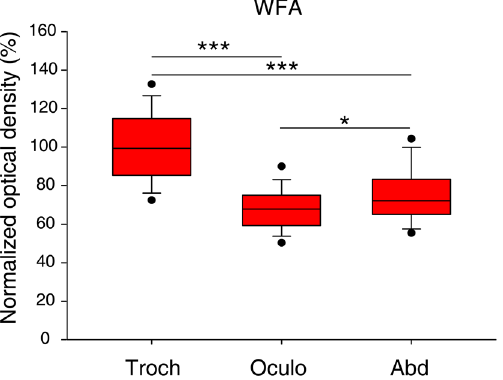
Figure 4. Optical densities of WFA reactions in the trochlear-, oculomotor- and abducens nuclei. Optical densities were normalized by the mean optical density of PNNs in the trochlear nucleus and expressed as percentages of this mean. Box plots represent the 10th, 25th, 50th 75th and 90th percentile values, lower and upper closed circles mark the 5th and 95th percentiles. There is a statistically significant difference in optical densities among the three nuclei (Kruskal–Wallis ANOVA on Ranks test, p < 0.001). Pairwise comparisons of optical densities revealed statistically significant difference between each pair of nuclei (Dunn’s post hoc test, ***p < 0.001, *p = 0.03).